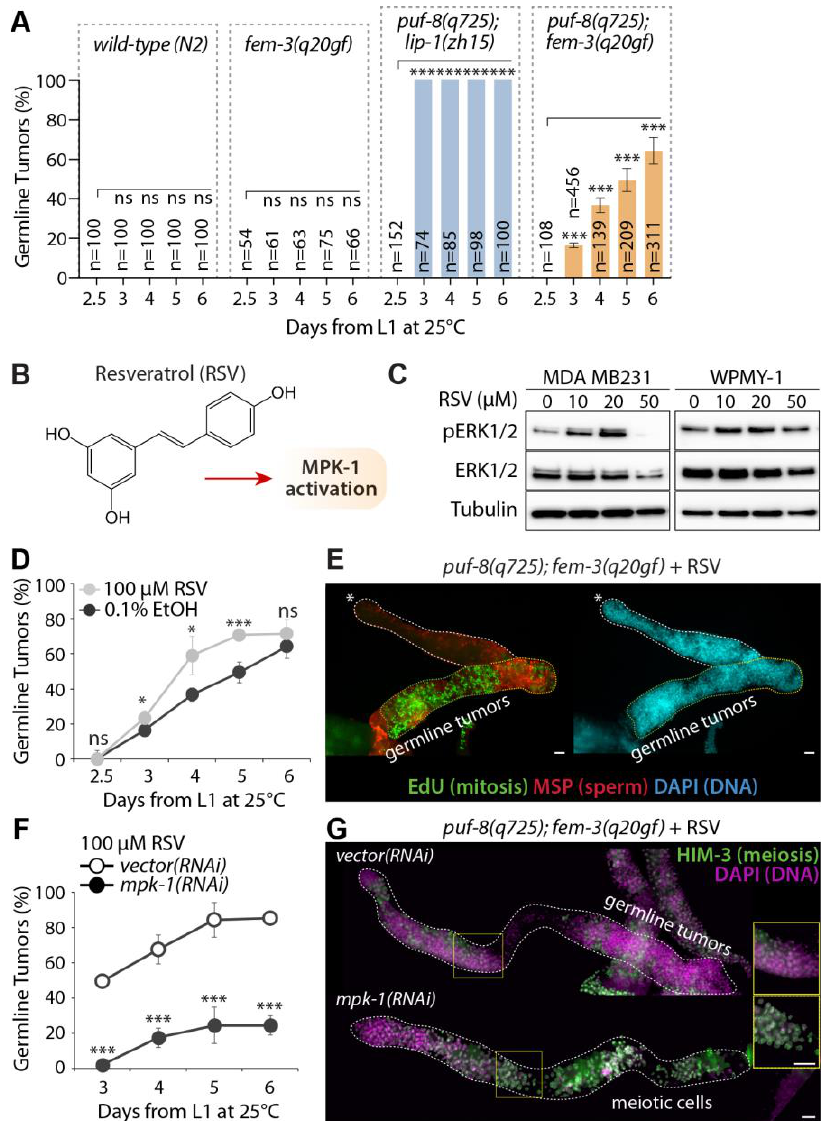
Figure 5. The activation of MPK-1 induces the formation of germline tumors via spermatocyte dedifferentiation in the absence of PUF-8. ( A ) % germline tumors. ( B ) Chemical structure of Resveratrol and its effect on MPK-1 activation. ( C ) Western blot. ( D ) The percentage of germline tumors at 25 °C. The germline phenotypes were determined at 2.5, 3, 4, 5, and 6 days after the L1 stage. ( E ) Staining of dissected adult hermaphrodite germline with EdU-labeling kit, anti-MSP, and DAPI. Scale bars are 10 μm. ( F ) The percentage of germline tumors at 25 °C. The germline phenotypes were determined at 2.5, 3, 4, 5, and 6 days after the L1 stage. ( G ) Staining of dissected adult hermaphrodite germline with anti-HIM-3 and DAPI. Scale bars are 10 μm. All experiments were performed in triplicate. The statistical significance was assessed by Student’s t-test without corrections for multiple comparisons. ***, p < 0.001; *, p < 0.05; ns, not statistically significant.